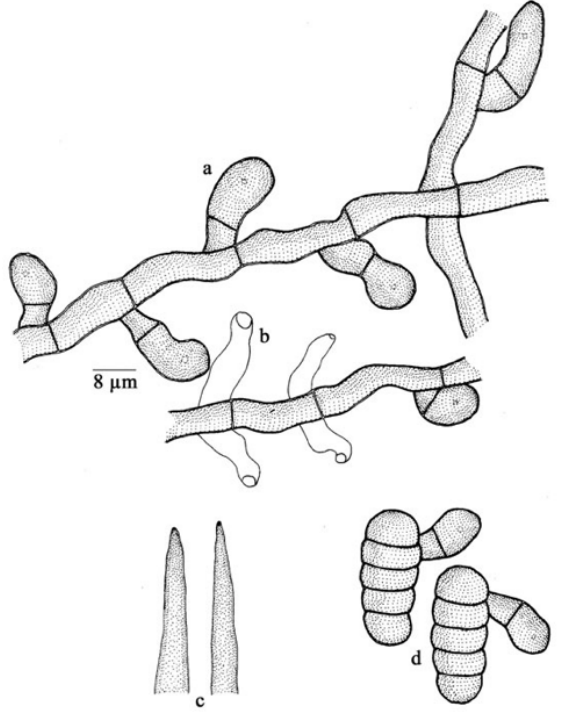
Figure 55. Meliola cannonii a - Appressorium; b - Phialide; c - Apical portion of mycelial setae; d -